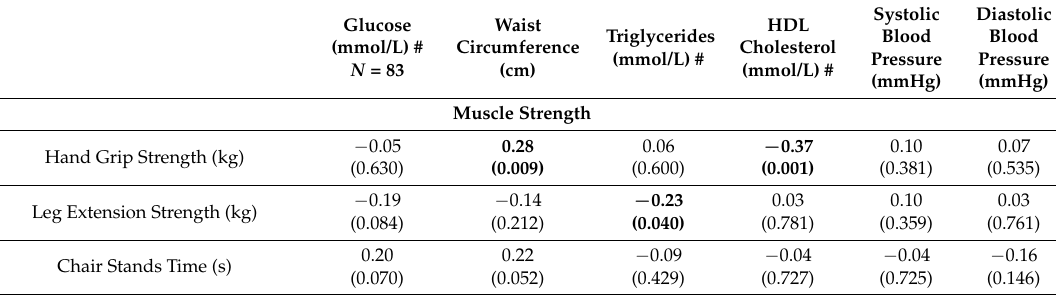
Table 3. Pearson’s correlation coefficients ( p -values) for components of metabolic syndrome and